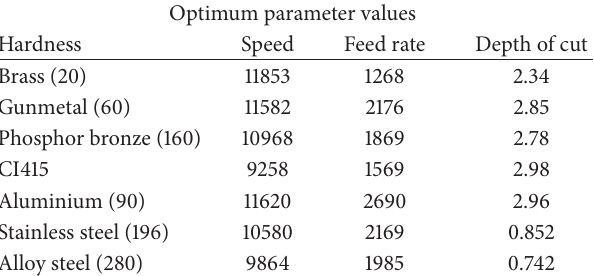
Table 6: Results for